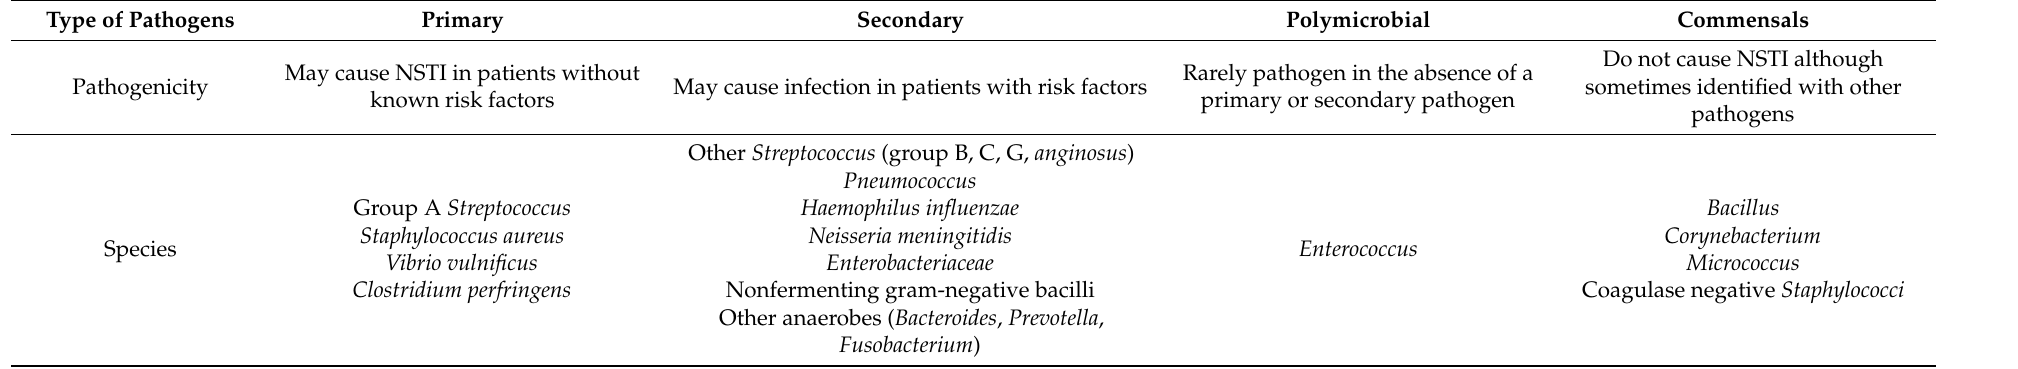
Table 1. Most frequently cultured microorganisms in NSTI. Classification adapted from Bruun et al.